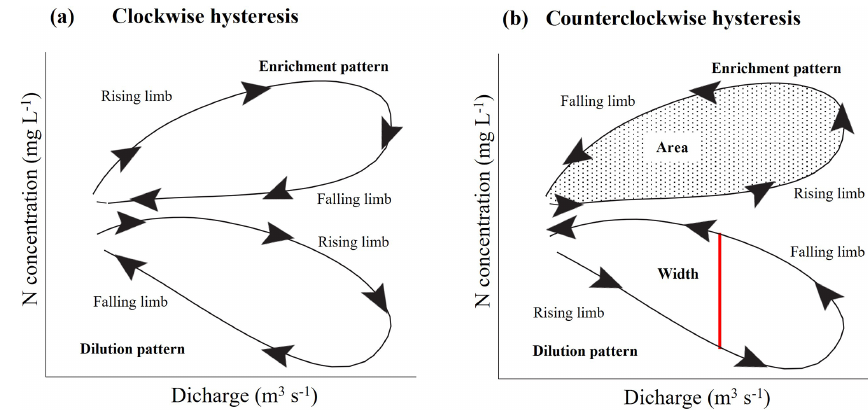
Figure 1. Idealized representation of (a) clockwise and (b) counterclockwise hysteresis loops, showing that each pattern can occur with either enrichment or dilution during the rising limb of the hydrograph. The loop width (size of the loop; i.e., the difference in concentration between the rising and falling limbs at the midpoint of discharge) and area are shown in panel (b)